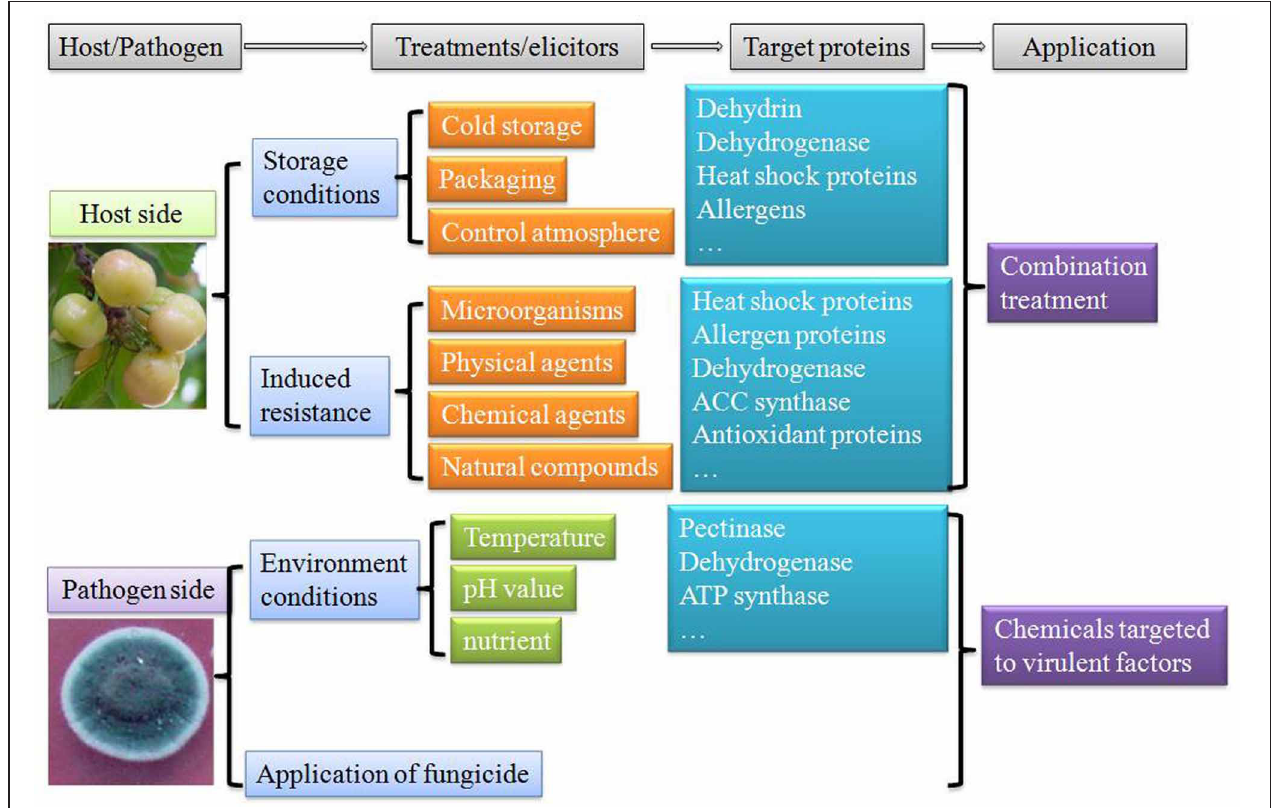
FIGURE 3 | Approaches to control postharvest decay and mechanisms involved based on proteomic study.